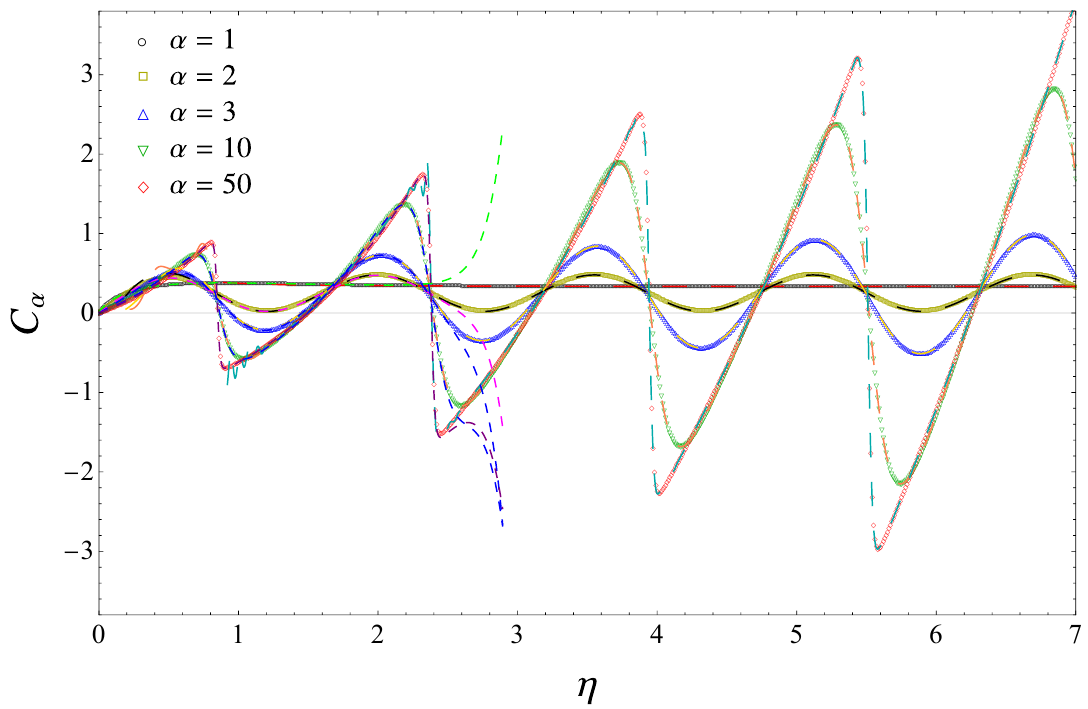
Figure 6. The quantity C α defined in (5.10): the data points correspond to (5.12) and the dashed lines are obtained from the small and large interval expansions derived in section 7 (see (7.4)) and section 8 (see (8.15), (8.17) and (8.21))